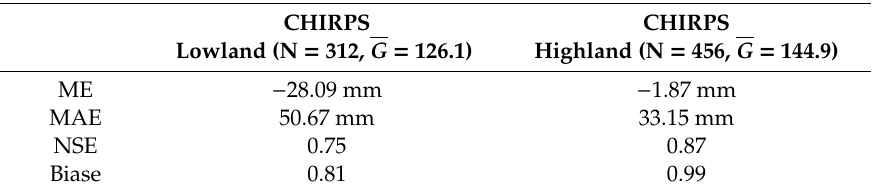
Table 6. Performance statistics by comparing monthly rainfall of the CHIRPS rainfall with gauge data for the lowland and highland stations during 2005–2015 to evaluate performance of CHIRPS monthly rainfall at the Beles Basin. N indicates the number of data pairs compared and 𝐺̅ is the average monthly rainfall (mm) of the gauge data.